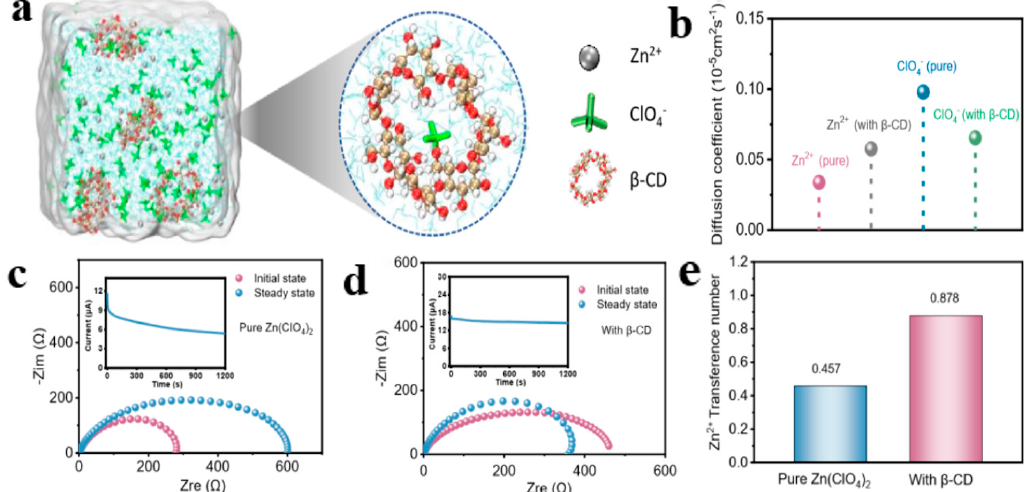
Figure 8. Theoretical simulations and electrochemical tests for explaining fast Zn 2+ diffusion mod- ulated via β -CD@ ClO 4 − complex. ( a ) 3D snapshot of Zn(ClO 4 ) 2 system with the β -CD additive gathered from MD simulations and partial enlarged snapshot representing ClO 4 − anion bind with β -CD successfully; ( b ) Diffusion coefficient of Zn 2+ and ClO 4 − in two above electrolyte systems (with and without β -CD additive) derived from MD simulations. EIS of the Zn||Zn symmetric batteries ( c ) without and ( d ) with the β -CD additive before and after polarization; inset: variation of current with time during polarization at an applied voltage of 10 mV at room temperature.( e ) Zn 2+ transference number (tZn 2+ ) comparison of two above electrolyte systems. Reproduced with permission [109]. Copyright 2022